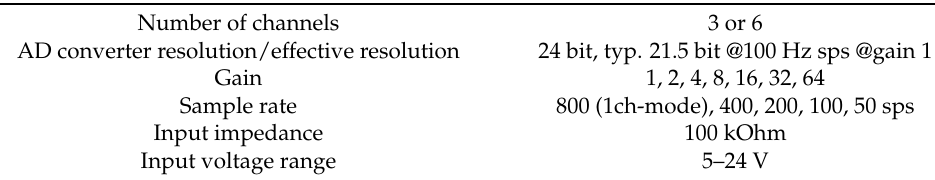
Table 3. Technical specifications of the digitizer board.